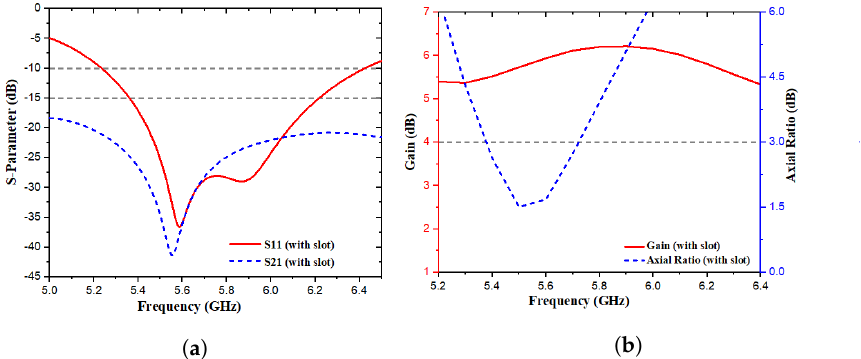
Figure 4. ( a ) Simulated S11/S21 of MIMO-CP with ground slot; ( b ) gain and AR of MIMO-CP with ground